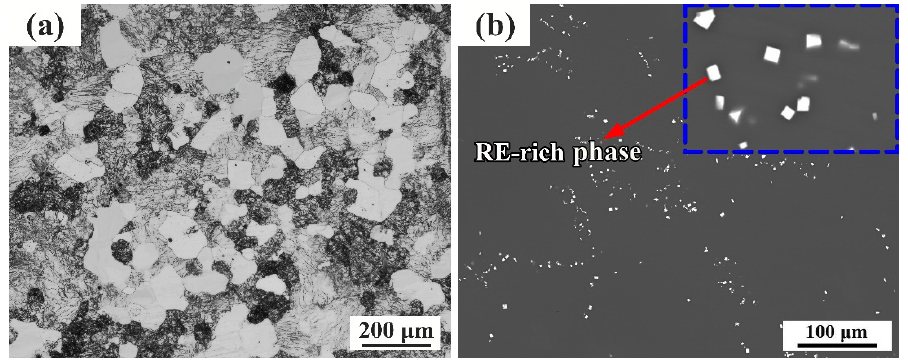
Figure 2. The optical microscope (OM) microstructure of as-cast alloy ( a ) and back-scattered electron (BSE) map of sample after homogenization treatment ( b ).